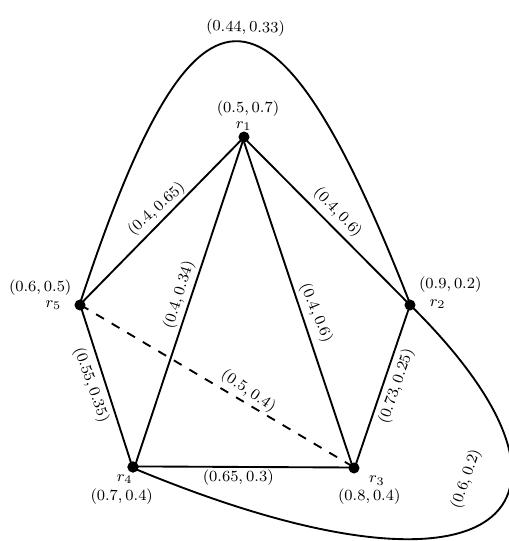
Figure 8. Pythagorean fuzzy planar graph with PF planarity (0.54,0.61). Figure 4.1: Pythagorean fuzzy planar graph with PF planarity (0.54,0.61)